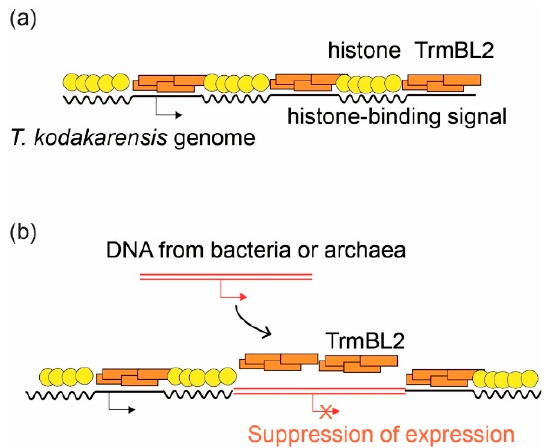
Figure 5. A model of how the transcription factor-like chromosomal protein TrmBL2 represses the expression of horizontally transferred genes in archaea. The chromosome of T. kodakarensis chromosome is shown as an example. ( a ) The genomic sequence and the state of chromosomal protein binding. Histone localization is determined by the histone binding signals on genomic DNA, and TrmBL2 bind to genomic regions with low histone localization because of its low sequence specificity. ( b ) When foreign DNA is obtained from bacteria, TrmBL2 essentially covers the entire region, because bacterial DNA does not have a histone-binding signal. This way, the expression of potentially harmful genes is repressed in the early stages of horizontal gene